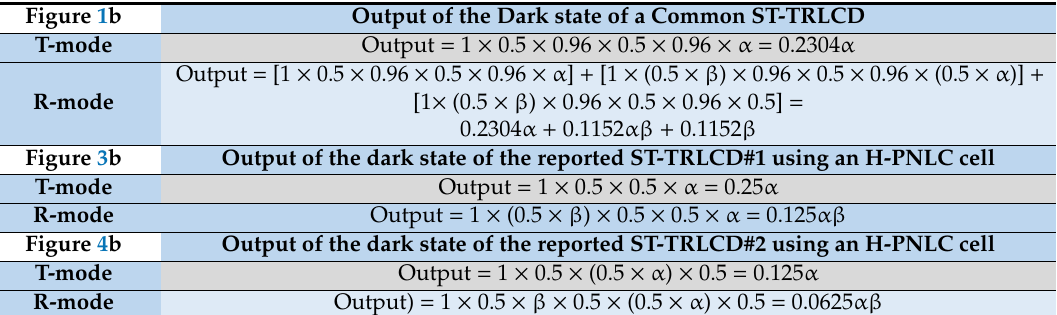
Table A1. The detailed calculations of the outputs of the dark states of the three ST-TRLCDs in Table 1 are listed below. Figure 1b Output of the Dark state of a Common ST-TRLCD T-mode Output = 1 × 0.5 × 0.96 × 0.5 × 0.96 × α = 0.2304 α